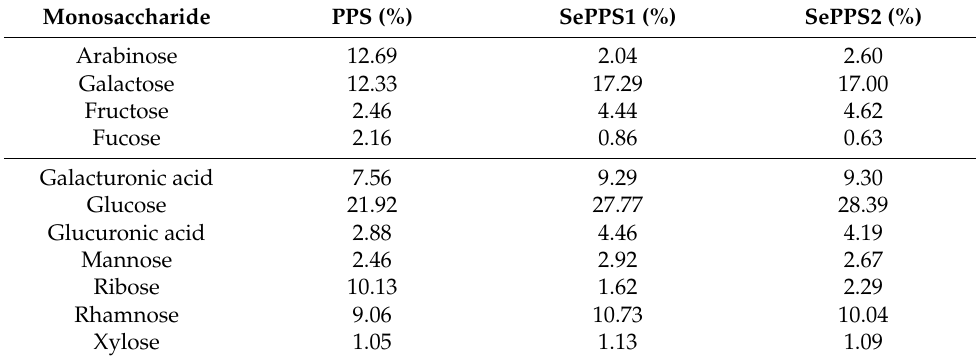
Table 2. Relative average percentages of eleven monosaccharides detected in P. oleracea polysaccharides (PPS) and two selenylated PPS products (SePPS1 and SePPS2).